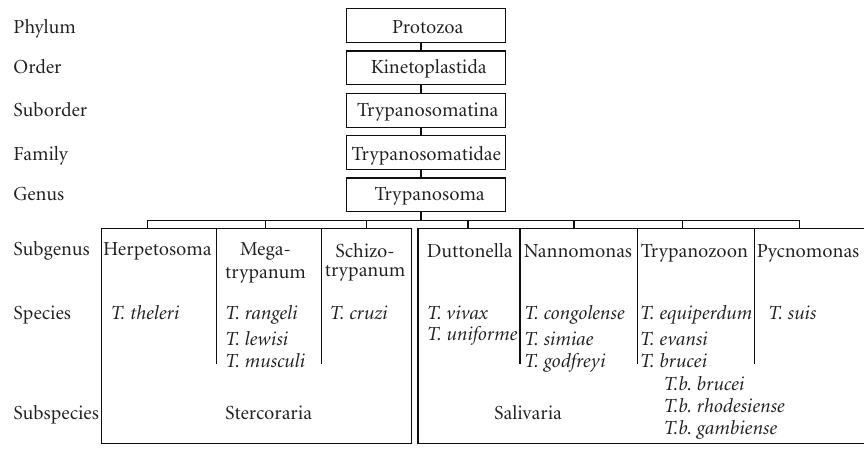
Figure 2: Classification of